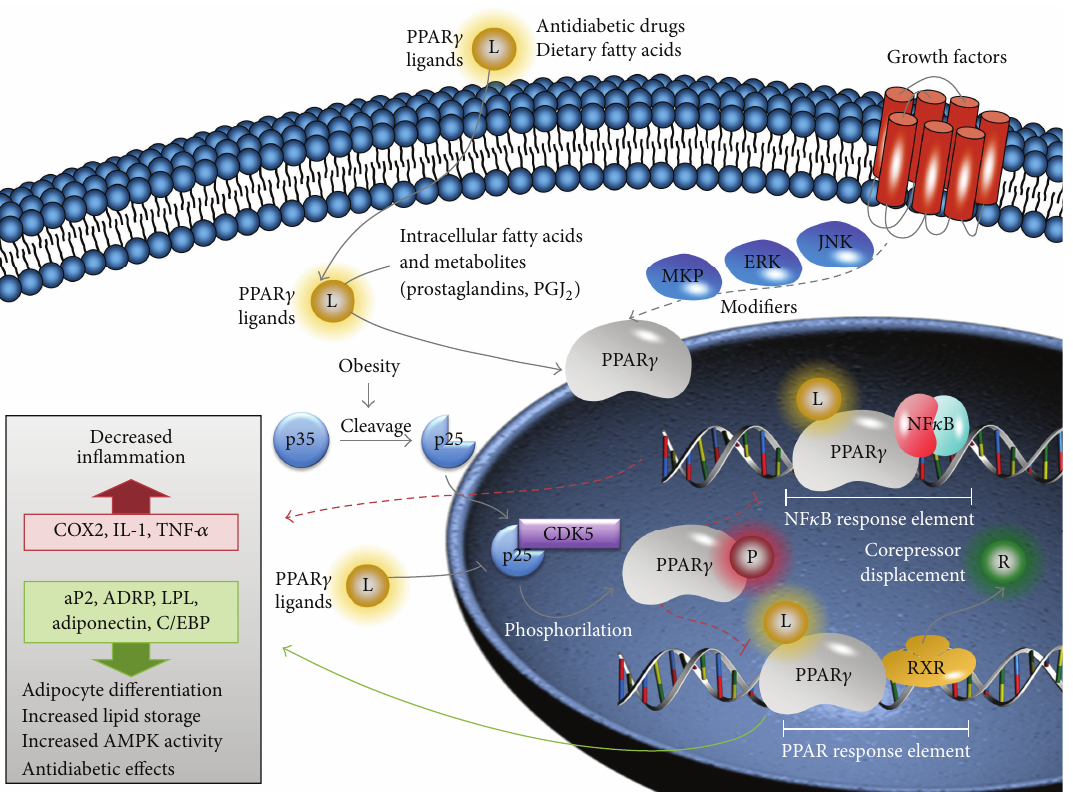
Figure 1: PPAR 𝛾 transduction pathway. PPAR 𝛾 has several extracellular and intracellular ligands that include dietary and bioactive lipids. Given its antidiabetogenic role, some PPAR 𝛾 ligands include antidiabetic drugs such as thiazolidinediones. PPAR 𝛾 is also modulated by several growth factor transduction pathways such as Jnk/Erk/MKP. It is also known that cyclin-dependent kinase 5 (Cdk5) bond to p25 (a product of the cleavage of p35 in obesity environment) inhibits PPAR 𝛾 pathway by its phosphorylation. As a transcriptional factor, PPAR 𝛾 binds to RXR (retinol X receptor) in order to transcribe several genes related to adipocyte differentiation and lipid storage in adipose tissue and increase insulin sensitivity in peripheral tissues by indirect increase of AMP kinase activity as well as several other antidiabetogenic effects. Moreover, PPAR 𝛾 blocks NF 𝜅 B signaling, thus reducing proinflammatory cytokines and